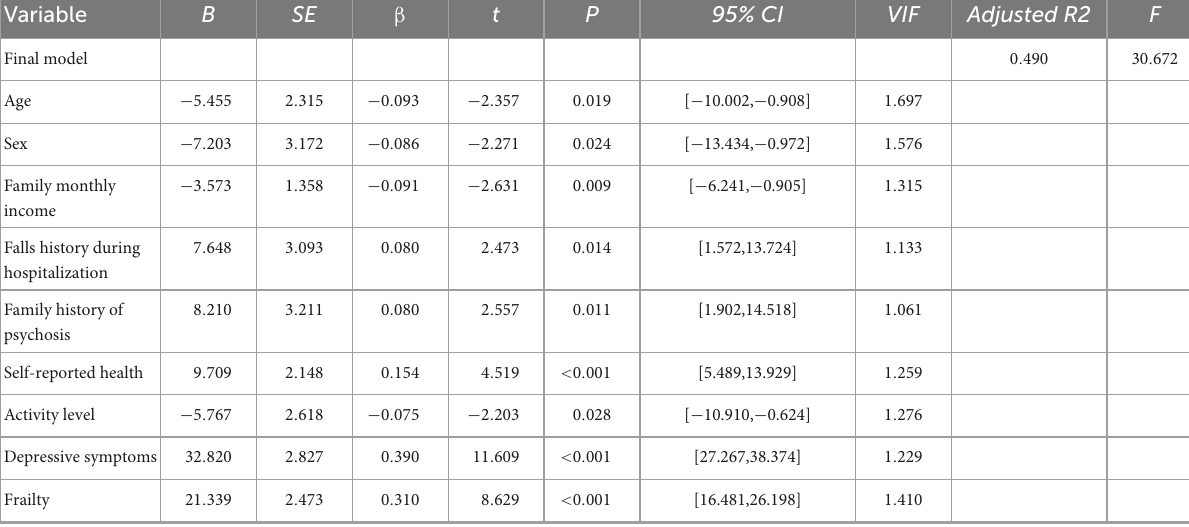
TABLE 5 Multivariable linear regression analysis of factors related to quality of